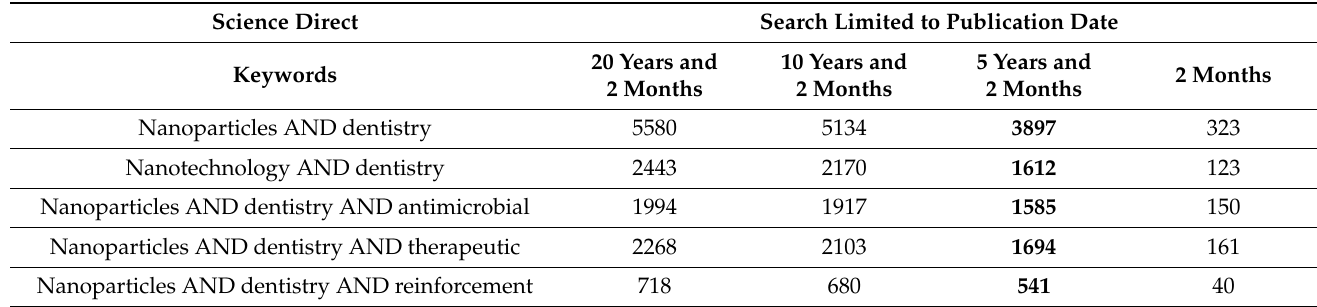
Table 1. Compilation of topic-related articles found in Science Direct database.